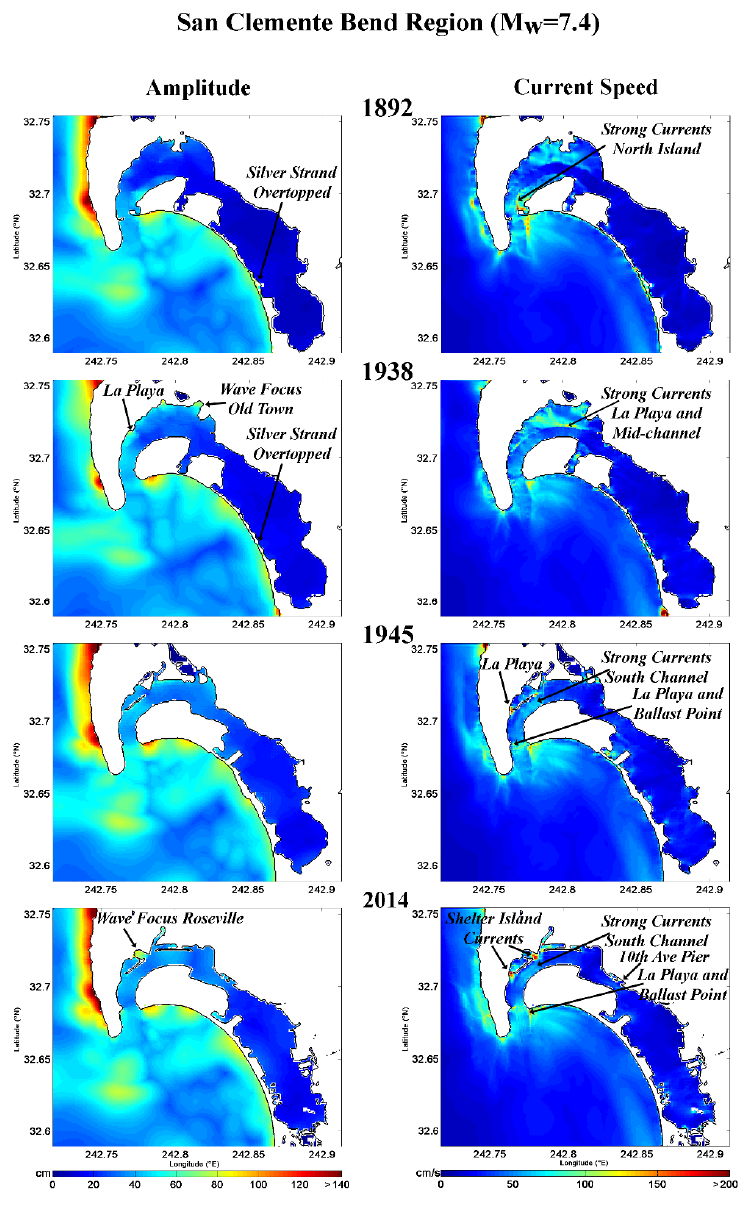
Figure 9. Maximum wave amplitude and maximum current distribution in San Diego harbor for four different configurations (1892, 1938, 1945, and 2014). A San Clemente fault rupture type of tsunami scenario was used to investigate changes in wave dynamics as a result of anthropogenic changes. Years indicate time tagging of large changes in the harbor. Left column shows wave heights in cm; right column tsunami currents in